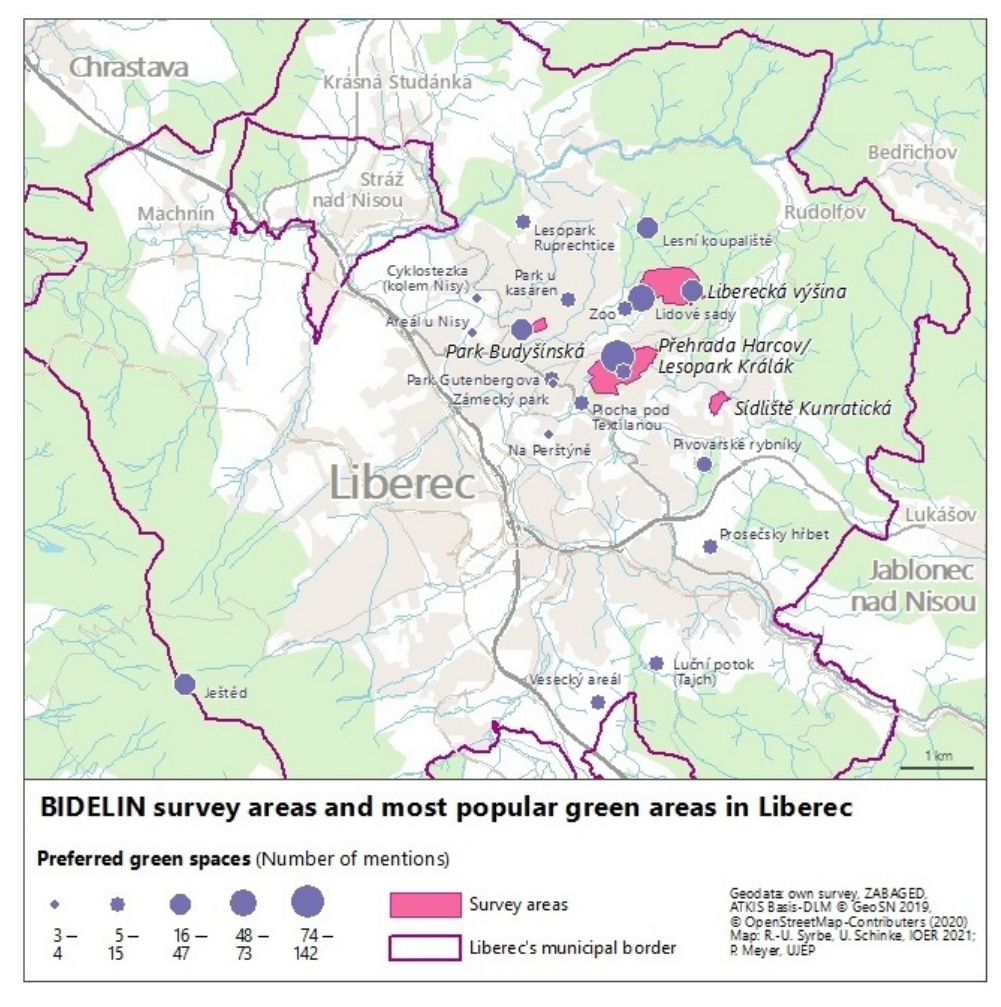
Figure 5. Survey areas in Liberec and the most popular green areas (named at least three times in an open question) (source: authors’ elaboration).